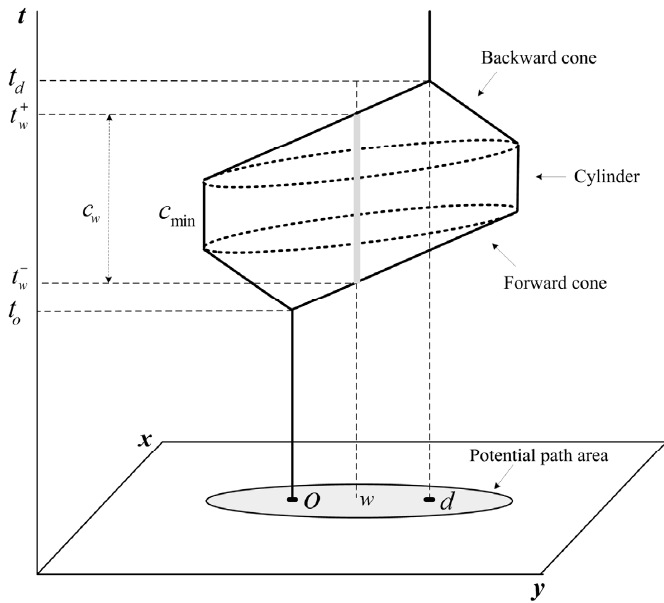
Figure 1. Space-time prism and related concepts.